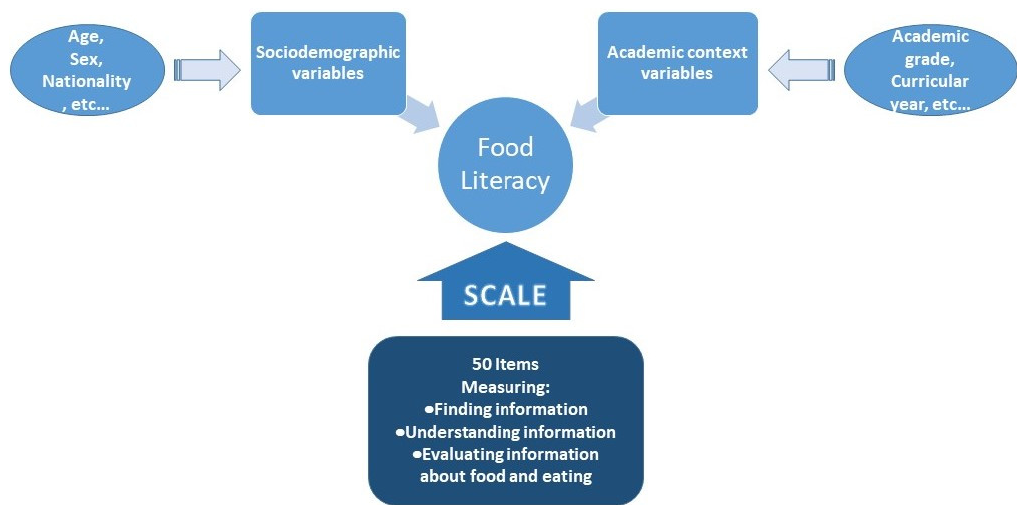
Figure 1. Schematic representation of the model to measure food literacy.